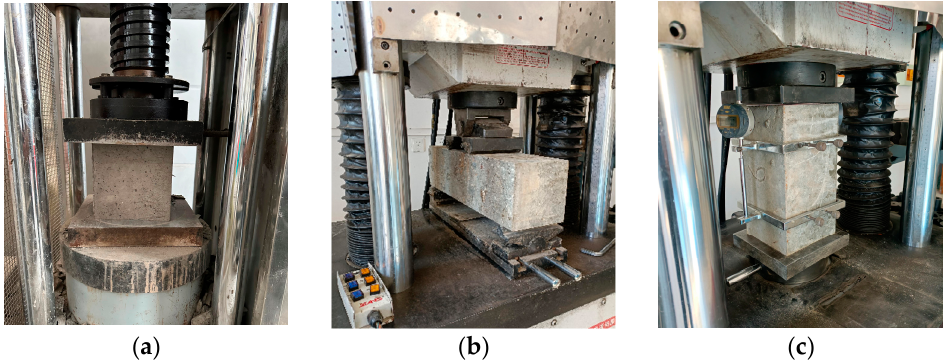
Figure 2. Mechanical property test of concrete. ( a ) Cube compressive strength. ( b ) Bending and tensile strength. ( c ) Elastic Modulus. Table 1. Mechanical properties of concrete.